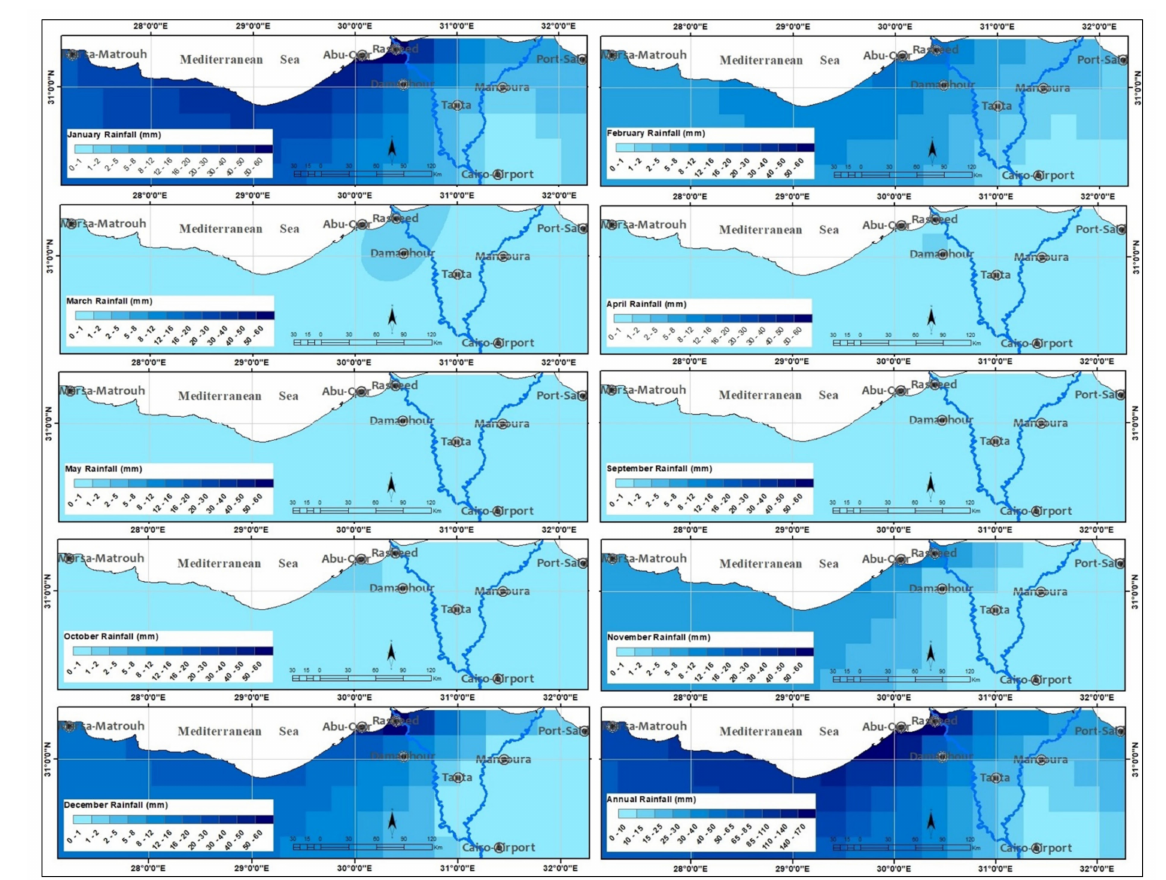
Figure 6. Spatial distribution of average monthly and annual rainfall using the best